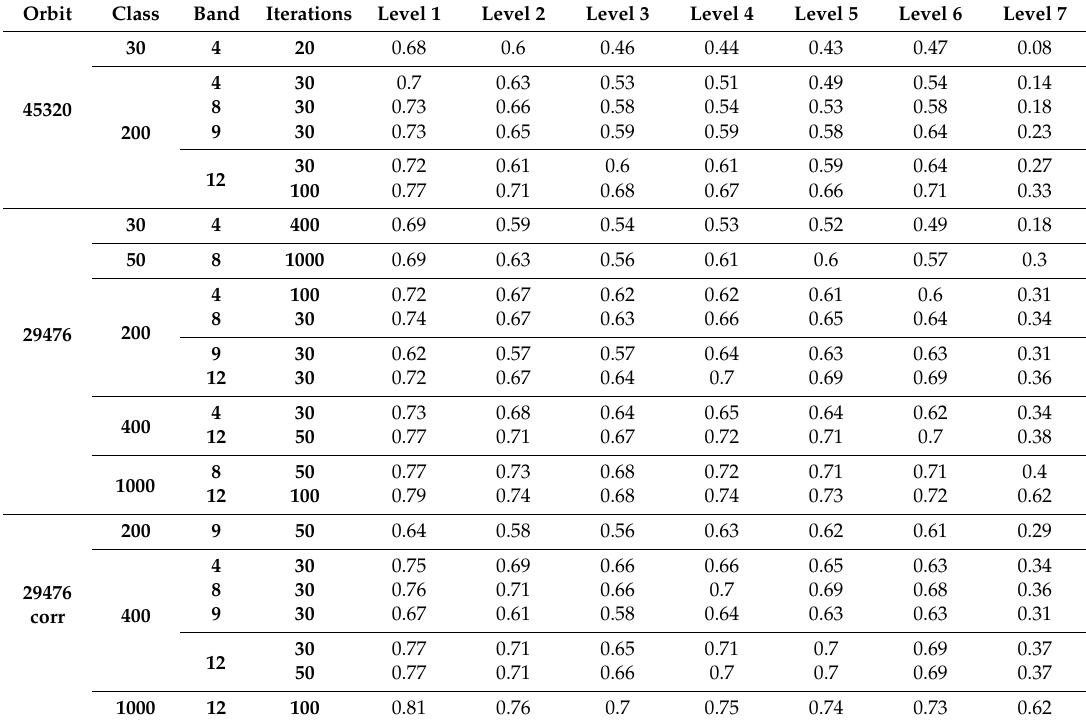
Table 3. Kappa coefficient classification